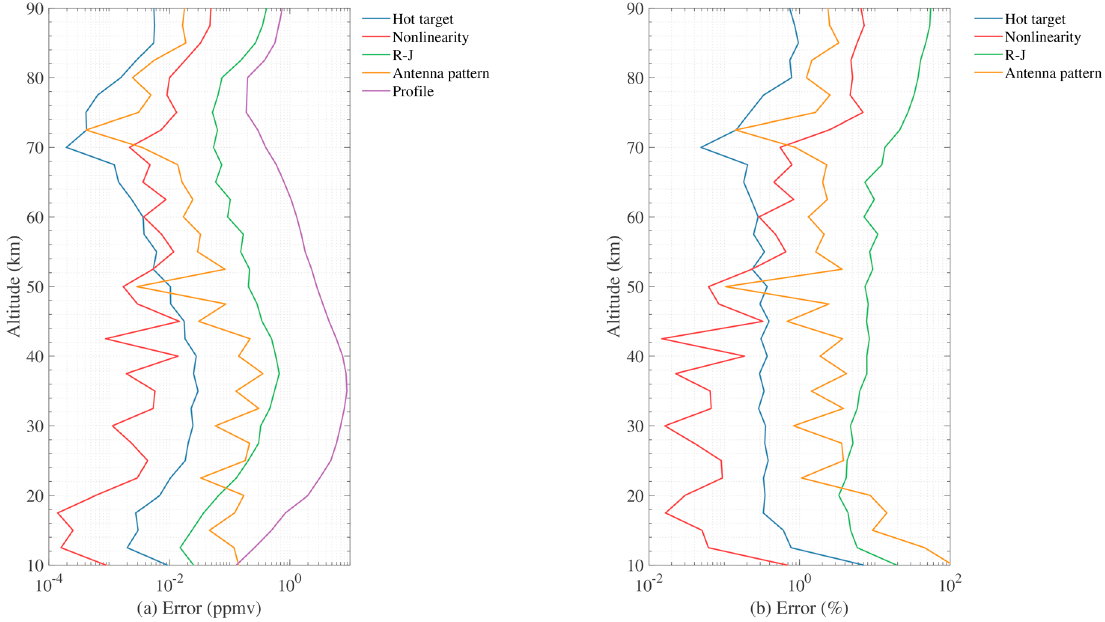
Figure 15. The O 3 retrieval errors induced by different calibration error sources: (a) absolute and (b) relative retrieval errors. The uncertainties assumed are summarized in Table 4.